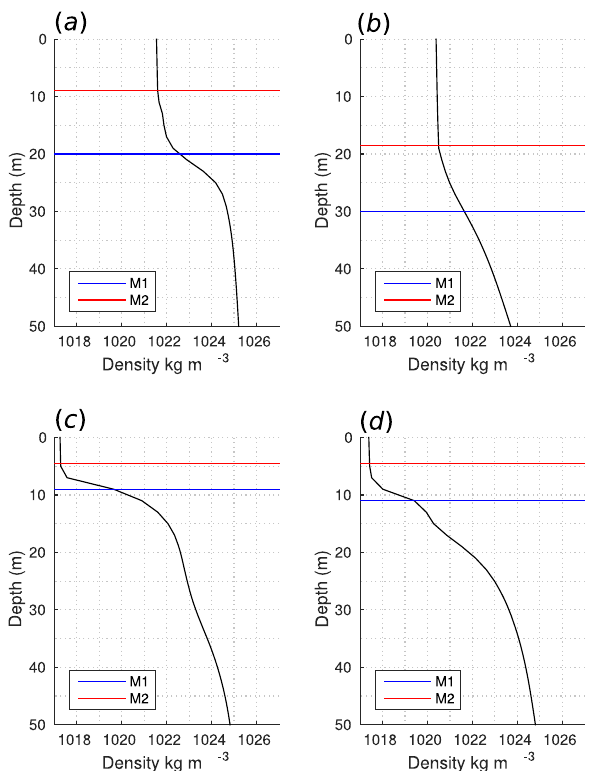
Figure 7. Methods M1 and M2 applied to selected ITP profiles, (a) ITP 1 on 13 December 2006 at 74.80 ◦ N, 131.44 ◦ W. (b) ITP- 43 on 27 November 2010 at 75.41 ◦ N, 143.09 ◦ W. (c) ITP 1 on 28 August 2006 at 76.96 ◦ N, 133.32 ◦ W. (d) ITP-13 on 30 July 2008 at 75.00 ◦ N, 132.78 ◦